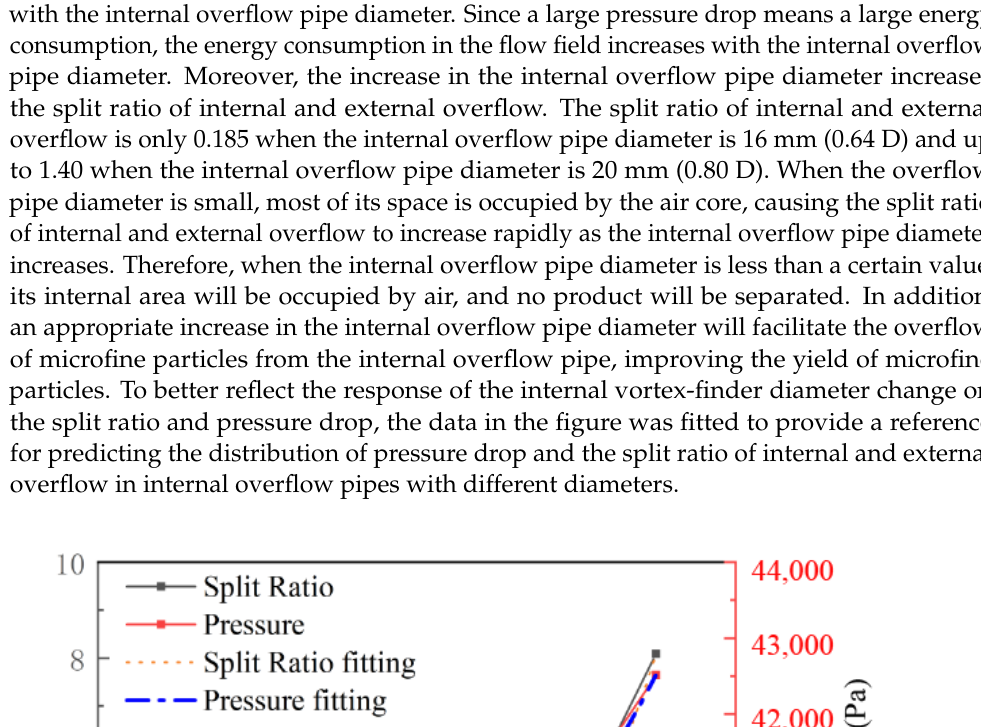
( d ) Figure 10. The movement track of liquid under different internal vortex-finder diameters. ( a ) 0.64D ( b ) 0.72D ( c ) 0.80D ( d ) 0.88D. 3.2. Impact of the Insertion Depth of the Internal Vortex-Finder on the Flow Field 3.2.1. Statistic Pressure Distribution Figure 11 shows the static pressure distribution of the hydrocyclone. It can be found that the change of the length of the internal overflow pipe has the same effect on the pressure field at different heights. Meanwhile, at a certain height, the radial pressure gradient of the flow field is larger when the internal overflow pipe length is less than or equal to the external overflow pipe length, and the pressure gradient reaches the maximum when the insertion depth of the internal and external vortex finders is the same. Since the direction of the pressure gradient is from the high-pressure area to the low- pressure area, a larger pressure gradient is favorable for the migration of fine particles from the wall to the axis. Thus, when the internal overflow pipe length is less than or equal to the external overflow pipe length, the content of fine particles in the external